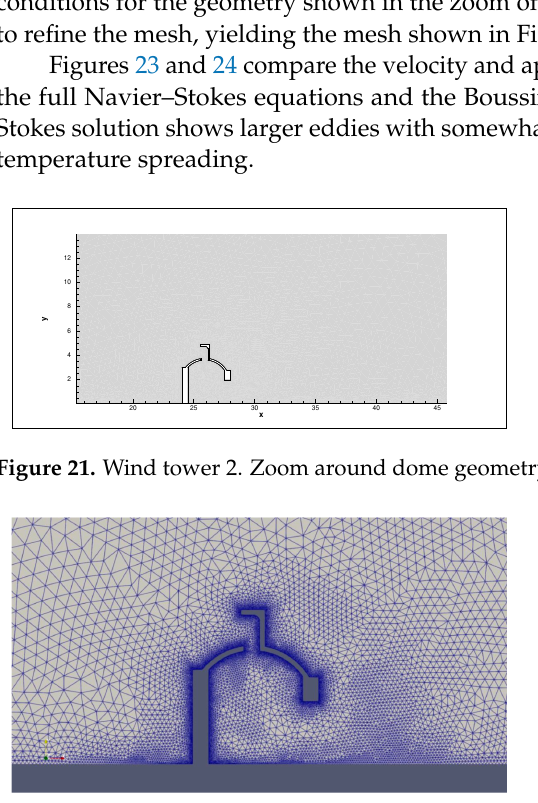
Figure 22. Wind tower 2. VMS T -adapted